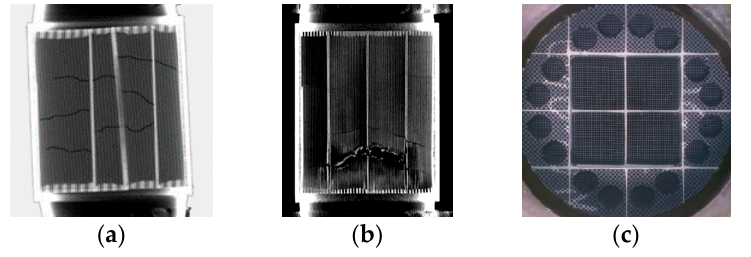
Figure 1. ( a ) Cracks on DPF substrate; ( b ) melted DPF; ( c ) partial unplugged